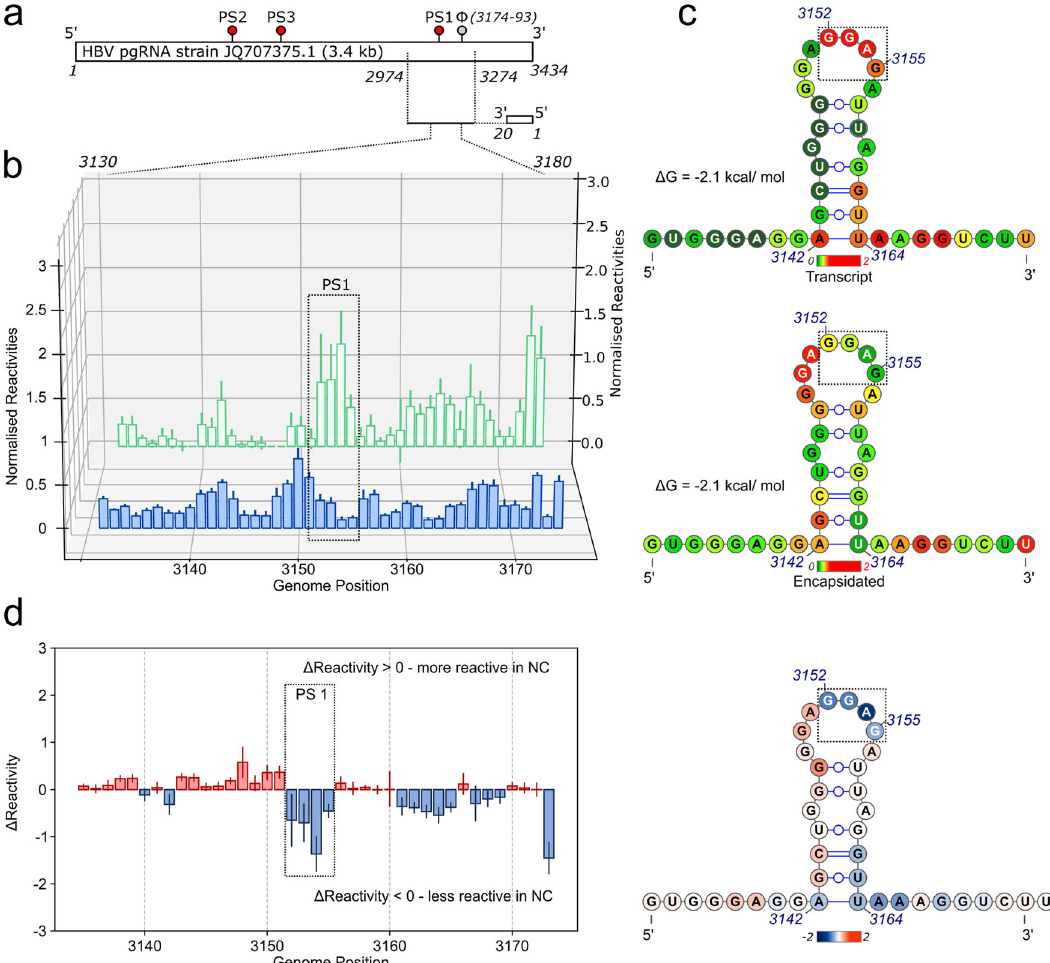
Fig. 5 RNA footprints of the PS1 region. a Protein-free transcripts of the gRNA, or following reassembly and puri fi cation of NCPs, were hydroxyl radical footprinted as frozen samples by exposure to X-rays 25,26,57 . RNAs were recovered from frozen samples. Reverse transcription from a 5 ′ fl uorescently-end- labelled primer complementary to the pgRNA 3 ′ -end was used to assess nucleotide reactivities in a fragment encompassing PS1 using capillary electrophoresis. b Waterfall plot of the per nucleotide reactivities and associated standard errors from triplicate samples of transcript (green) or NCP (blue). Data found in Supplementary Data 2. c Secondary structures of the PS1 folds showing their XRF reactivities. Nucleotides are coloured red to green depending on their relative reactivity on exposure to the beamline (red → green = reactive → inert (reactivity of 2.0 → 0)), key shown below each fold. d Left: The average reactivity at each nucleotide across the PS1 sequence is shown. Red/blue indicate positions more/less reactive in the NCP. Right: Average reactivity at each nucleotide shown upon the secondary structure of PS1. Nucleotides are coloured blue/red depending on their reactivity within the NCP (blue → red = less → more reactive ( Δ reactivity of − 2.0 → 2.0)), key shown below the PS1 fold. Data found in Supplementary Data